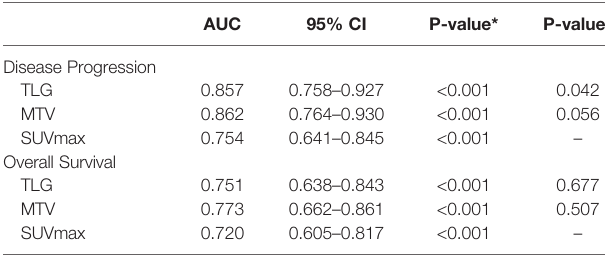
* P-values of ROC curve analysis. † Comparison of AUC values between SUVmax, TLG, and MTV using Z test method. SUV, standard uptake value; MTV, metabolic tumor volume; TLG, total lesion